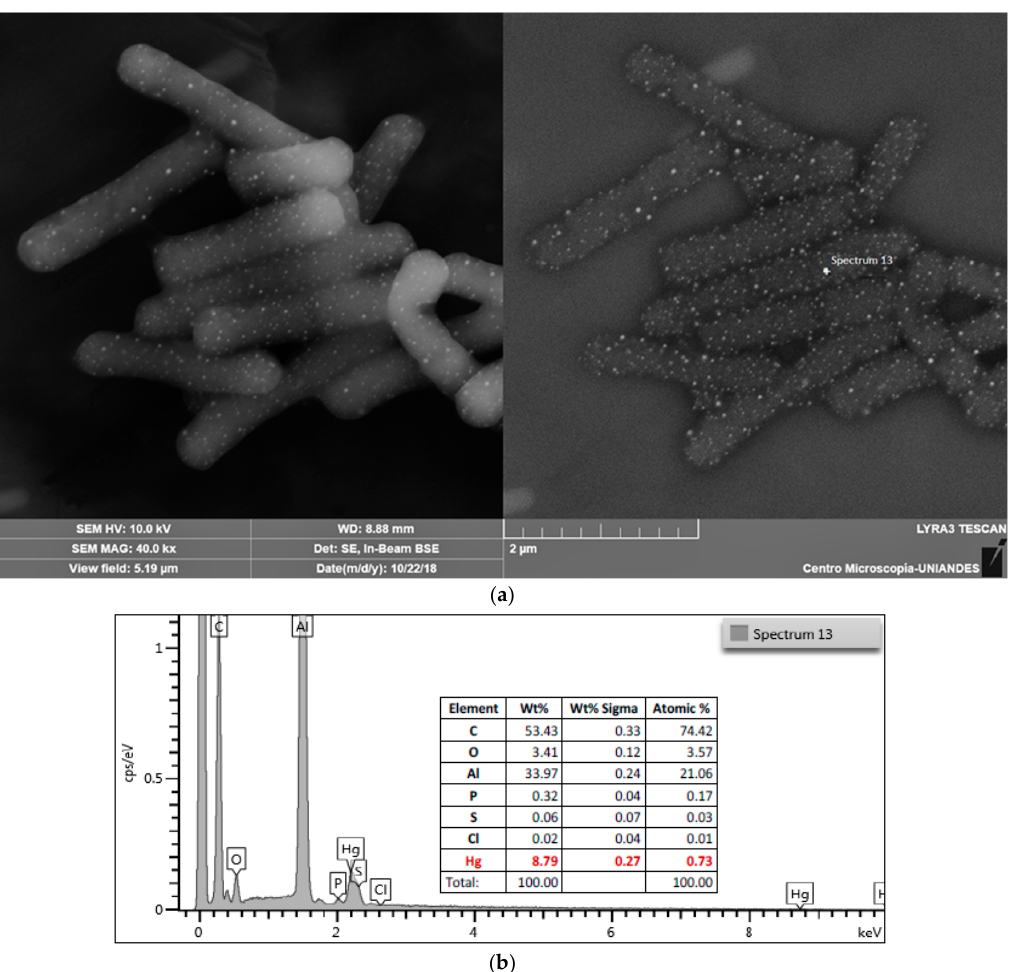
Figure 1. EDS-SEM analysis of L. sphaericus III(3)7 live cells after 1 h in contact with HgCl 2 . ( a ) Image taken at 10 kV by detection of secondary electrons and backscattered electrons; ( b ) Data from energy dispersive spectroscopy of punctual area “Spectrum 13”.